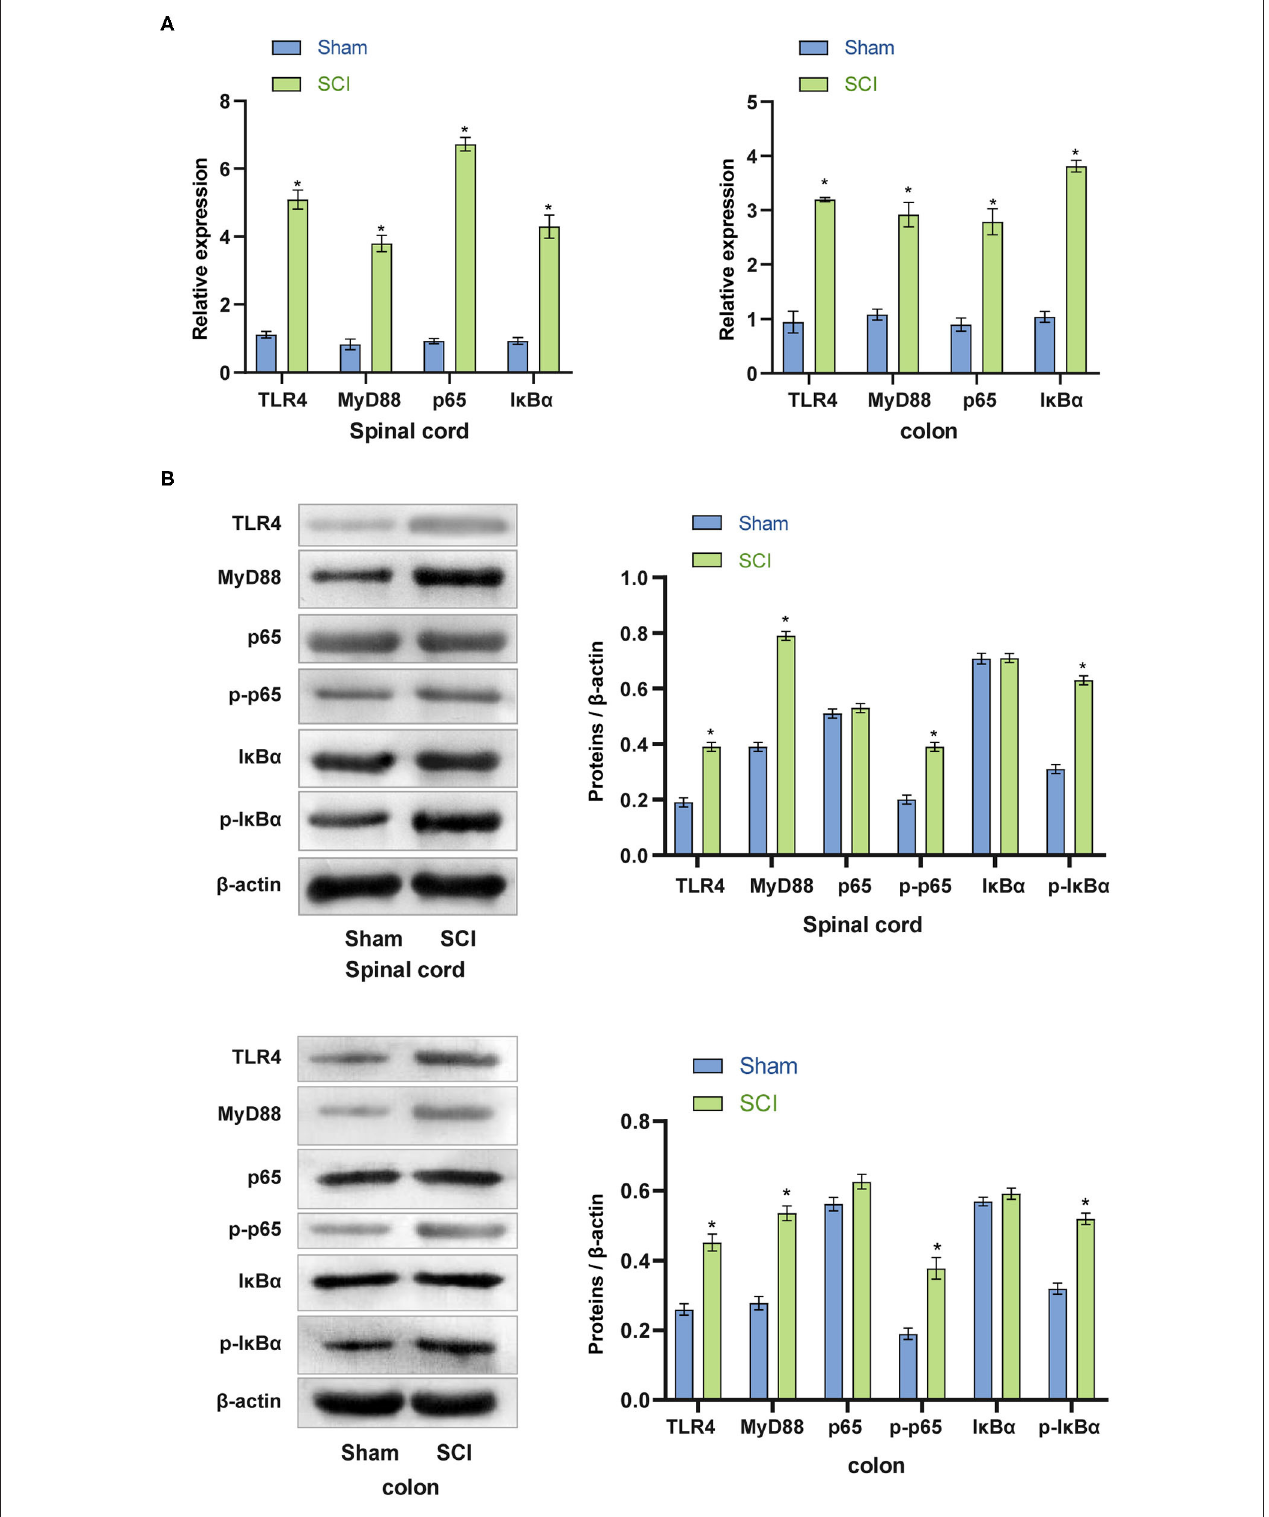
FIGURE 4 | Activation of the TLR4/MyD88 signaling pathway in the spinal cord and colon of SCI mice. (A) qRT-PCR was used to analyze the expression of TLR4, MyD88, p65, I κ B α in the spinal cord and colon tissues. (B) The protein expression of TLR4, MyD88, p-p65, and p-I κ B α increased significantly in SCI mice. * P < 0.05 compared with the Sham group. The unpaired t -test was used to analyze comparisons between two groups n = 5.